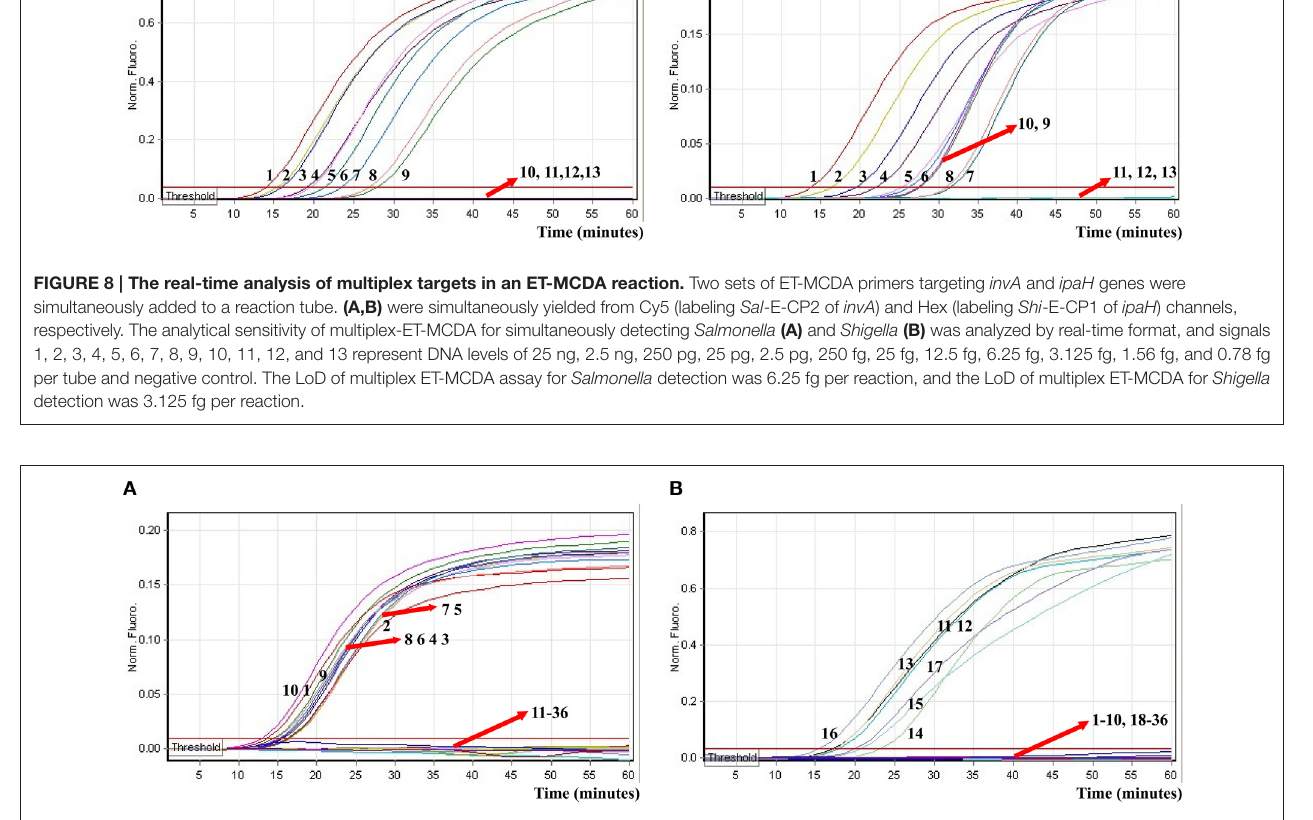
FIGURE 9 | The analytical specificity of multiplex ET-MCDA detection for different strains. The multiplex ET-MCDA amplifications were conducted using different genomic DNA templates and were monitored by means of real-time format. (A,B) were simultaneously generated from HEX and Cy5 channels. Signals 1-10, Shigella flexneri strains of serovar 1d (ICDC-NPS001), 4a (ICDC-NPS002), 5a (ICDC-NPS003), 2b (ICDC-NPS004), 1b (ICDC-NPS005), 3a (ICDC-NPS006), 3b (ICDC-NPS008), Shigella boydii , Shigella sonneri, and Shigella dysenteriae ; signals 11–15, Salmonella Choleraesuis (ICDC-NPSa001), Salmonella Dublin (ICDC-NPSa002), Salmonella Enteritidis (ICDC-NPSa003), Salmonella Typhimurium (ICDC-NPSa004), Salmonella Weltevreden (ICDC-NPSa005); signals 16 and 17, two Salmonella strains of unidentified serotype; signals 18-35, Listeria monocytogenes stains of serovar 1/2a (EGD-e), 4c (19116), Enteroinvasive E. coli , Enteropathogenic E. coli , Enterotoxigenic E. coli , Enteroaggregative E. coli , Enterohemorrhagic E. coli , Plesiomonas shigelloides , Yersinia enterocolitica , Bntorobater sakazakii , Enterobacter cloacae , Enterococcus faecalis , Vibrio parahaemolyticus , Vibrio vulnificus , Bacillus cereus , Staphylococcus aureus , Campylobacter jejuni, and Pseudomonas aeruginosa , signal 36, negative